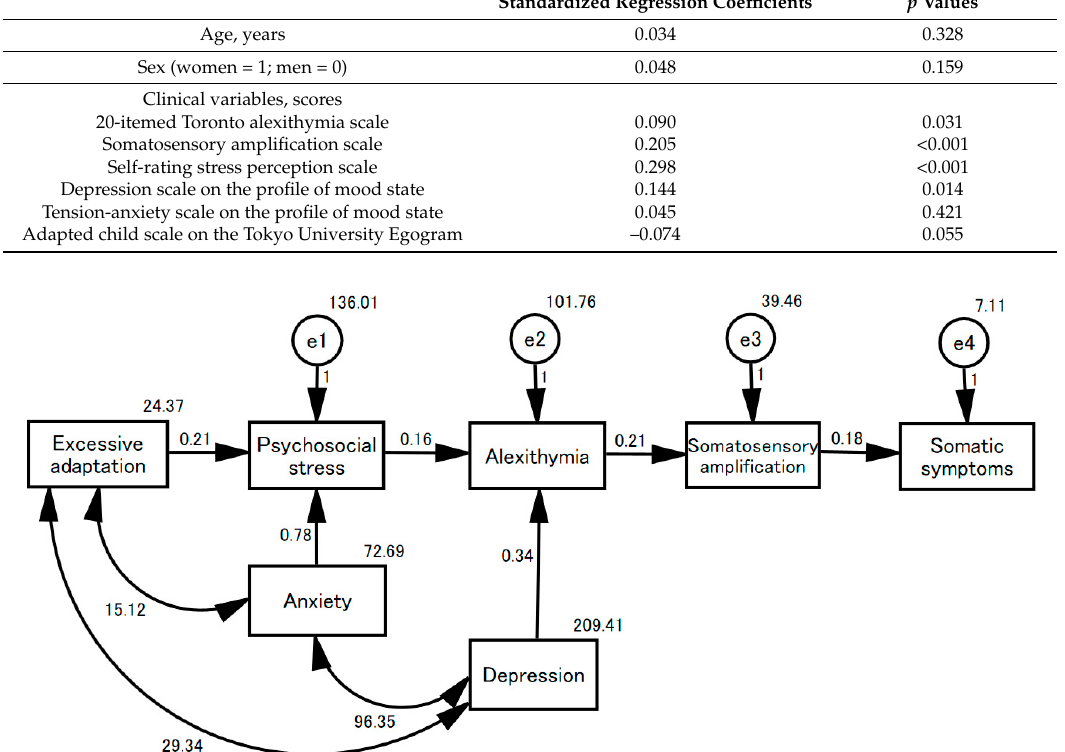
Figure 1. A model of somatic manifestation of psychosomatic illness. This structural equation model examines seven clinical variables in 604 psychosomatic outpatients. “Excessive adaptation” as reflected on the TEG Adapted Child scale; “anxiety” as scored on the POMS tension–anxiety scale; “depression” as revealed by the POMS depression scale; “psychosocial stress” as scored on the Stress Perception Scale; “alexithymia” as revealed by the TAS-20; and “somatosensory amplification” as shown by the SSAS. “Somatic symptoms”: the total number of somatic